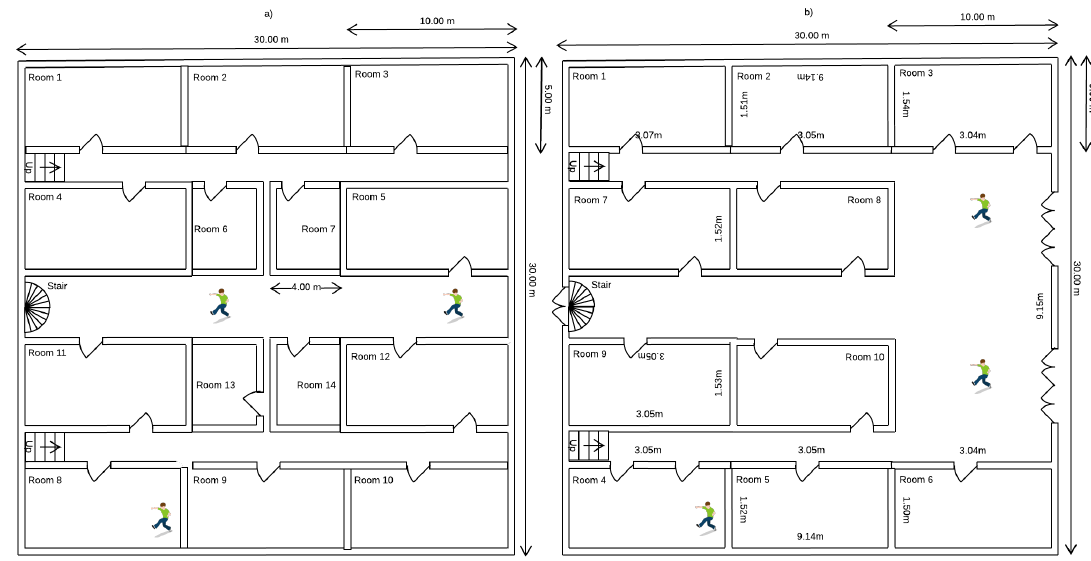
Figure A2. Scheme of the Building: ( a ) 30-storey building; ( b ) Ground